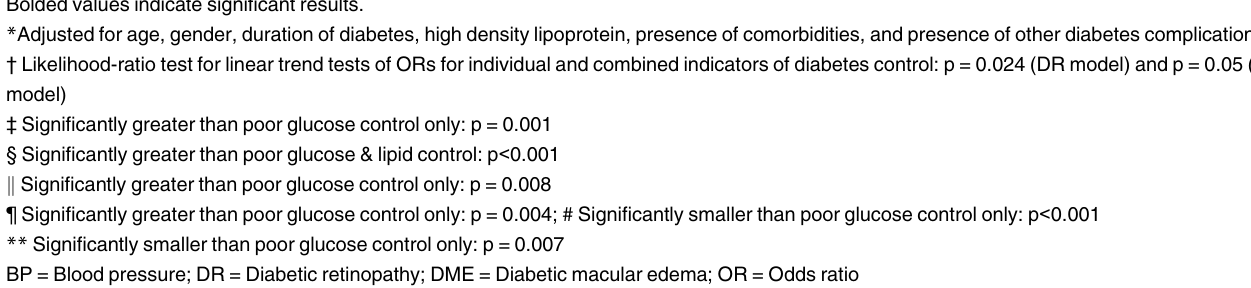
Bolded values indicate significant